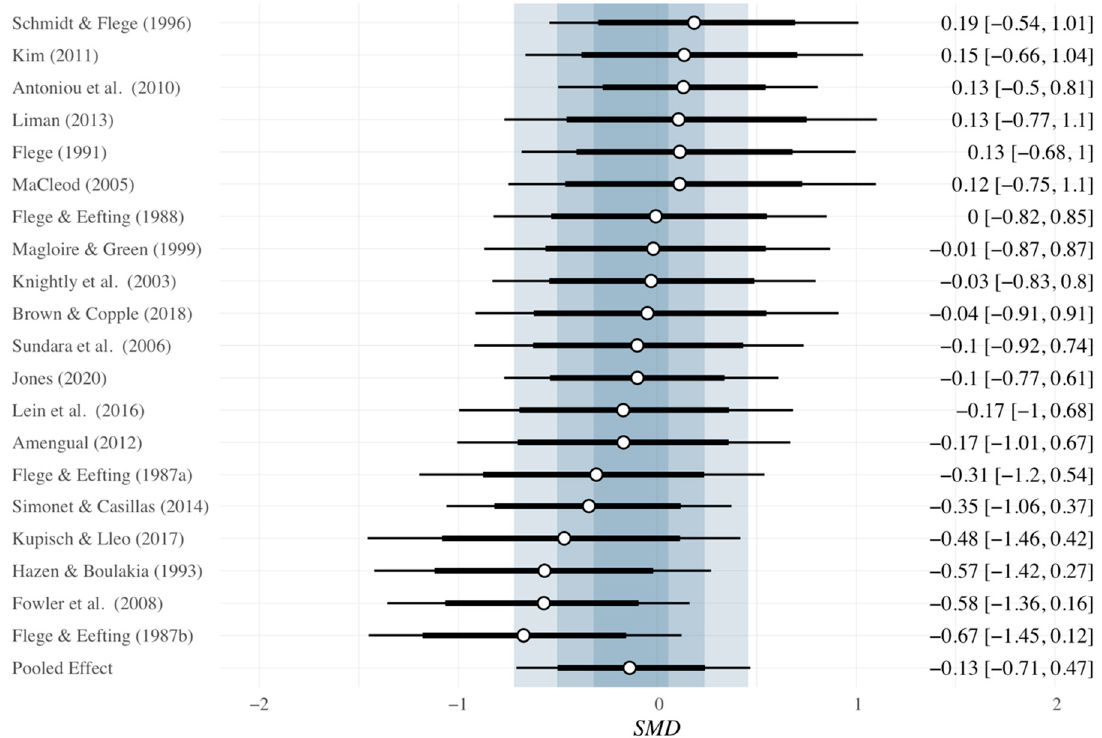
Figure 2. Summary of posterior model estimates for individual studies (vertical axis) and the effect size (SMD, horizontal axis). White points represent posterior medians and horizontal bars capture the ± 95% and 80% credible intervals, which are also printed along the right vertical margin. The vertical shaded rectangle illustrates ± 95%, 80%, and 50% credible intervals around the posterior median of the pooled effect.